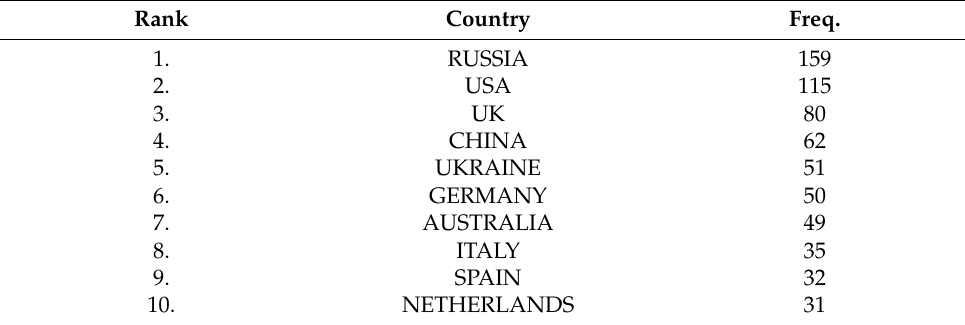
Figure 3. Countries’ scientific production (2015–2019). Table 9. Top 10 countries’ scientific production during 2015–2019 (Freq.).